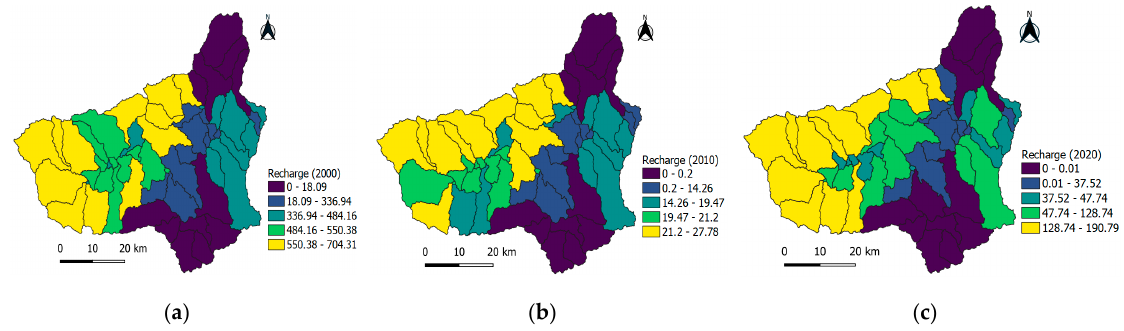
Figure 7. Spatiotemporal pattern of groundwater recharge: ( a ) 2000, ( b ) 2010, and ( c ) 2020 reference LULC periods.